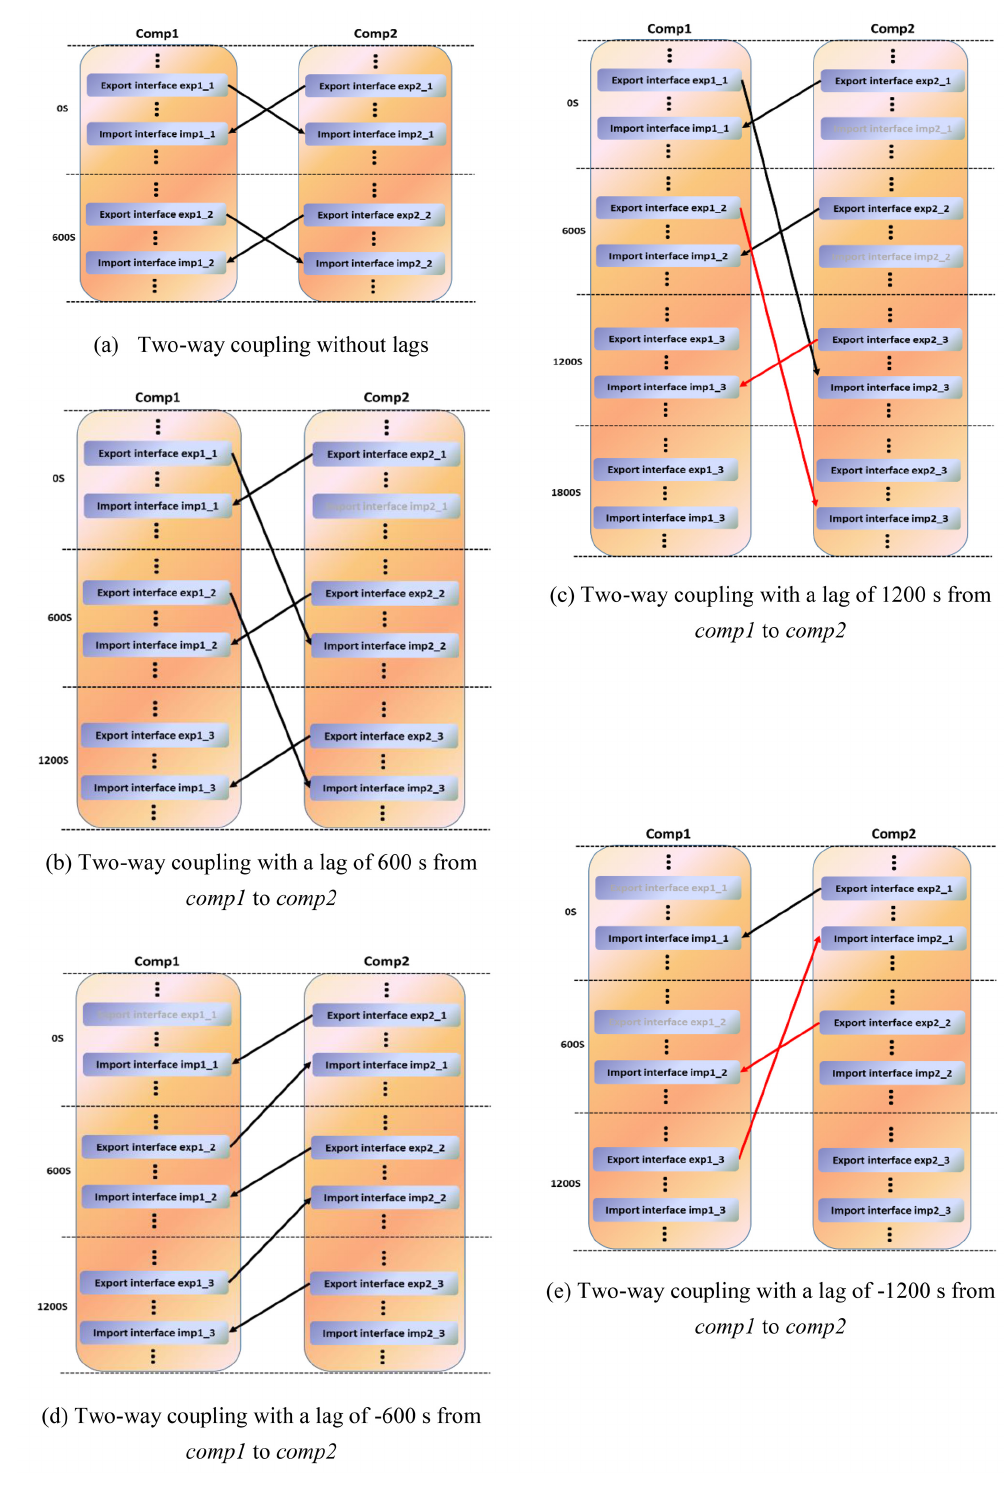
Figure 7. Sample two-way couplings with different lag settings. A coupling interface with light grey words means that it will not be executed, because it corresponds to the coupling interface executed at the model time earlier than the start time (0s) of the model